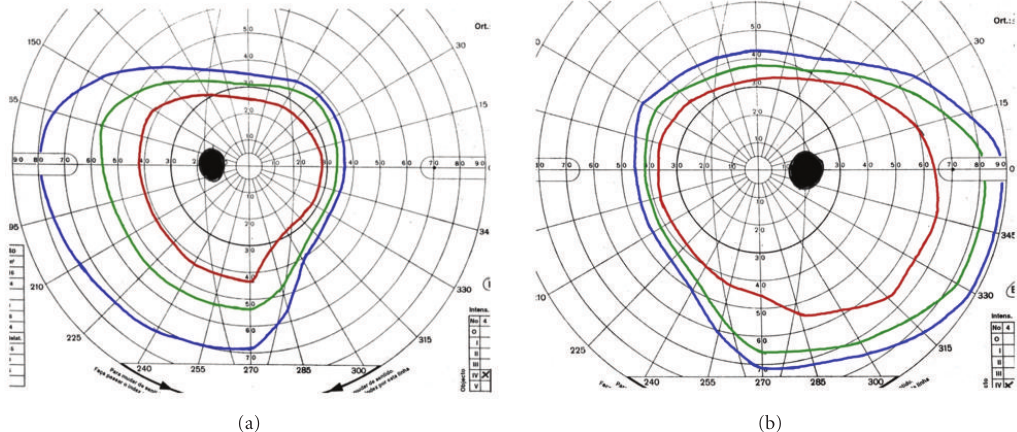
Figure 1: Goldmann perimetry left eye (a) and right eye (b) shows an enlarged blind spot more evident on the right eye and constriction of the superior and nasal fields especially in the left eye.